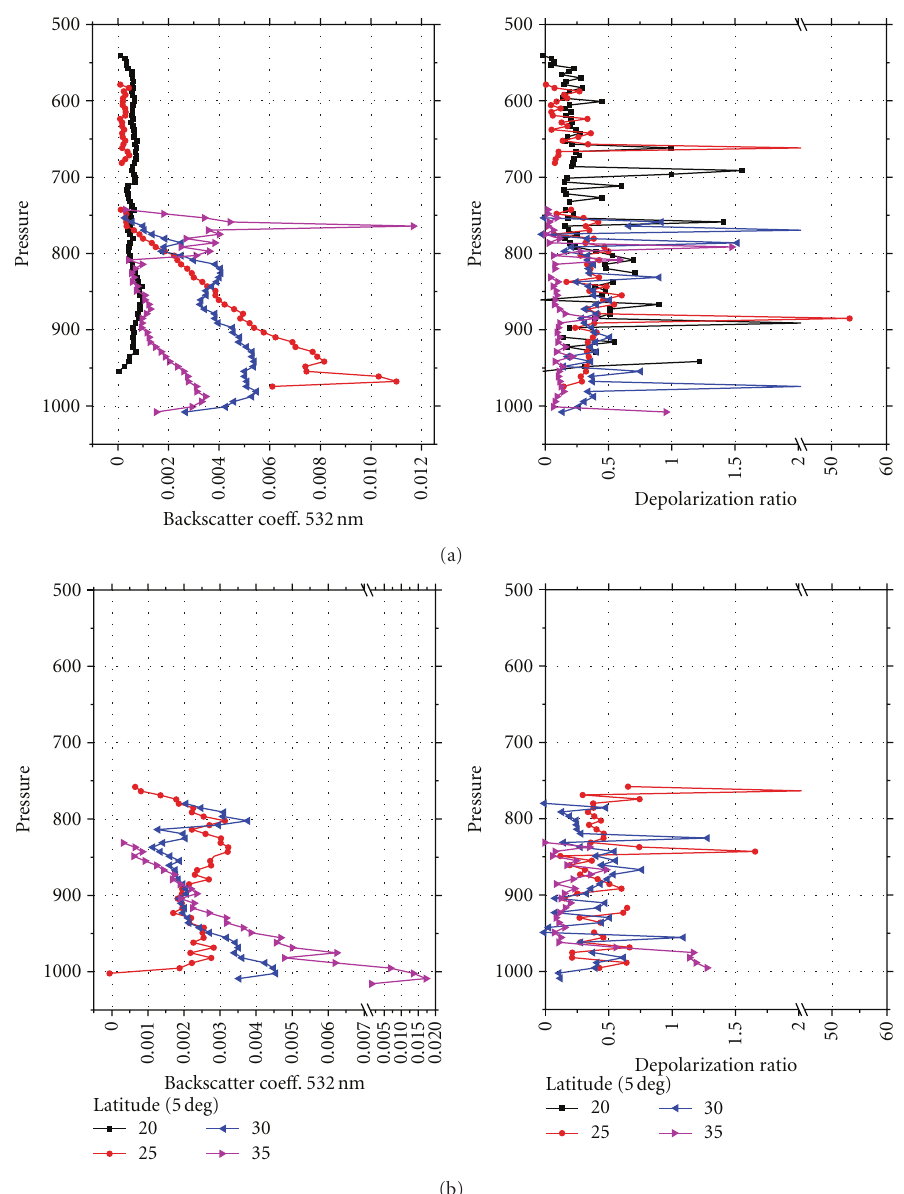
Figure 8: Latitude step-wise variation of CALIPSO measured variables (backscatter coe ffi cient and depolarization ratio) averaged over 5-degree latitude for nighttime (a) and daytime (b) conditions on 5 February